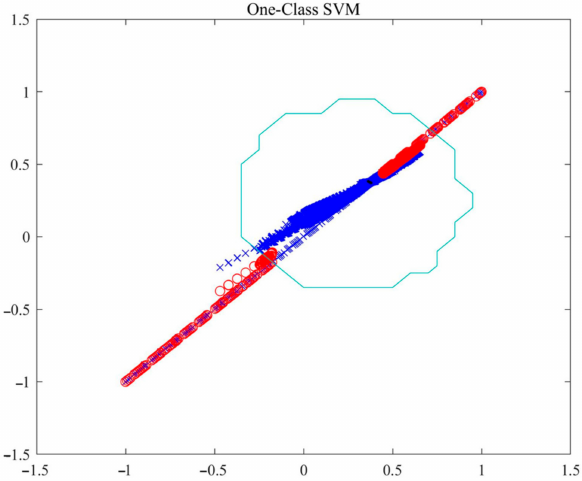
Figure 7. Classification diagram of outliers in the OCSVM